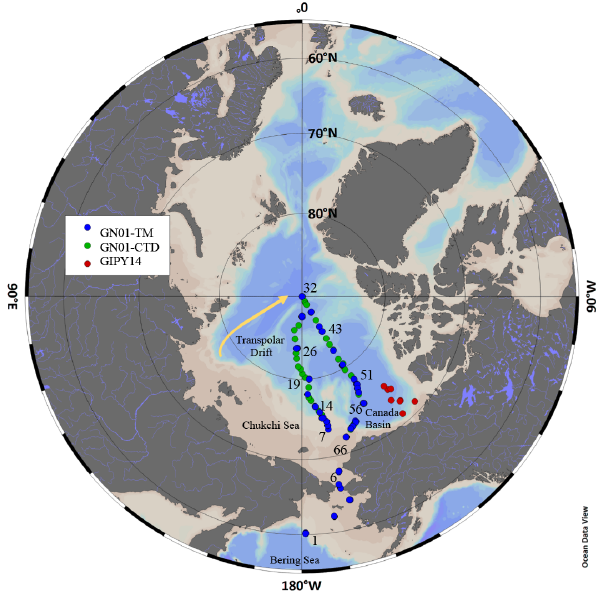
Figure 1. Standard CTD sampling stations (green) and trace metal rosette (TM) sampling stations (blue) from the GN01 expedition in 2015, and trace metal sampling locations from the GIPY14 expedi- tion in 2009